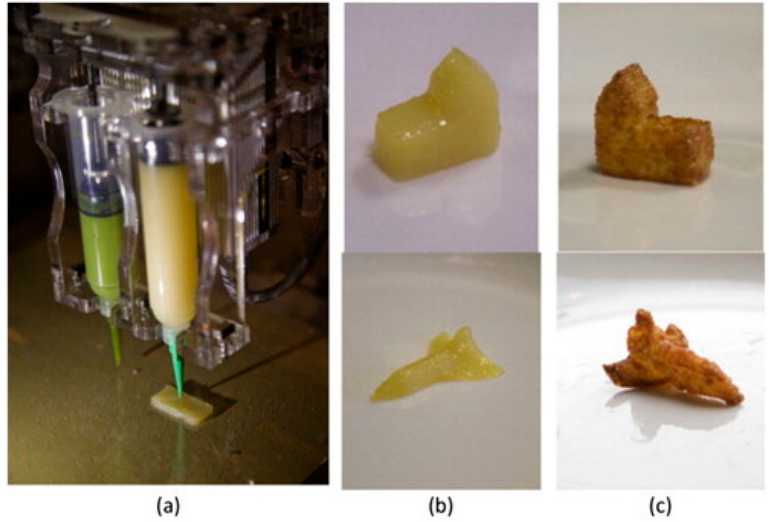
Figure 6. ( a ) Three-dimensional printing of scallop meat; ( b ) 3D-printed samples before frying; and ( c ) 3D-printed samples after frying. Picture taken from an article by He et al. [31].